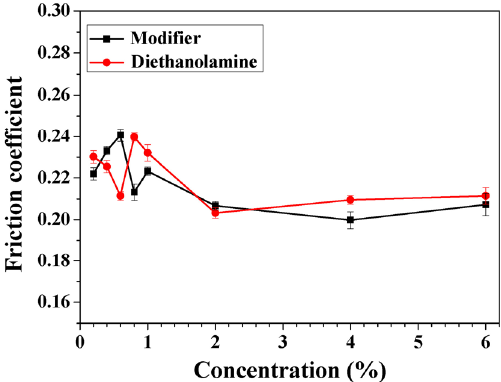
Fig. 6 Variations of the friction coefficient of the steel–silicon sliding pairs with concentration under the load of 2.0 N lubricated by distilled water containing modifier and diethanolamine (speed: 0.02 m/s, time: 30